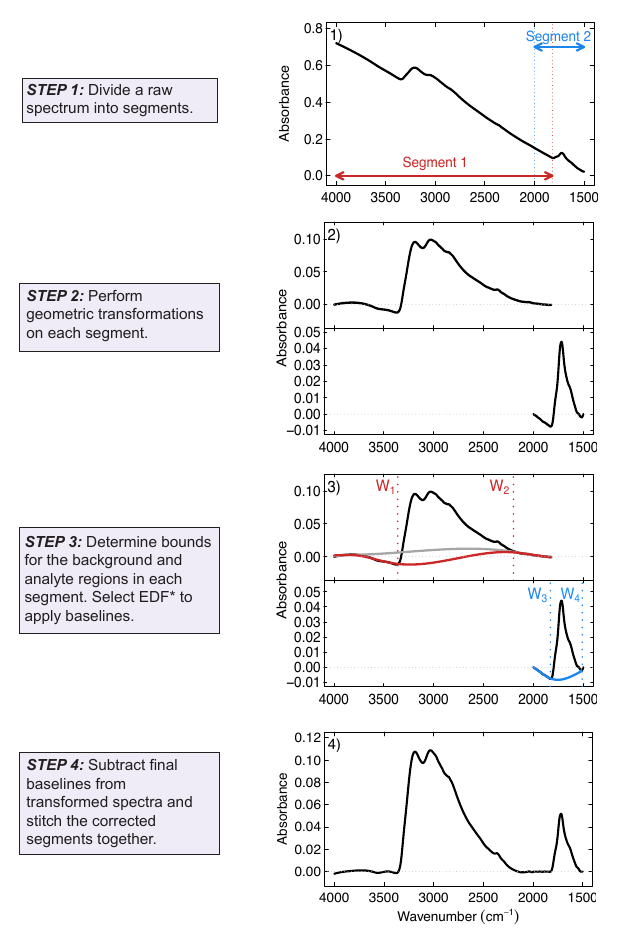
Figure 2. (1) Uncorrected spectrum partitioned into two segments: Segment 1, 4000–1820cm − 1 and Segment 2: 2000–1500cm − 1 . (2) Transformed segments with zero first and last absorbance val- ues. (3) Upper panel: initial baseline (gray), final baseline estimated iteratively via a non-negativity constraint (red). Red vertical lines delineate background and analyte regions: W 1 = 3360cm − 1 and W 2 = 2220cm − 1 . Lower panel: final baseline (blue). Blue vertical lines delineate background and analyte regions: W 3 = 1820cm − 1 and W 4 = 1520cm − 1 . (4) Resultant corrected